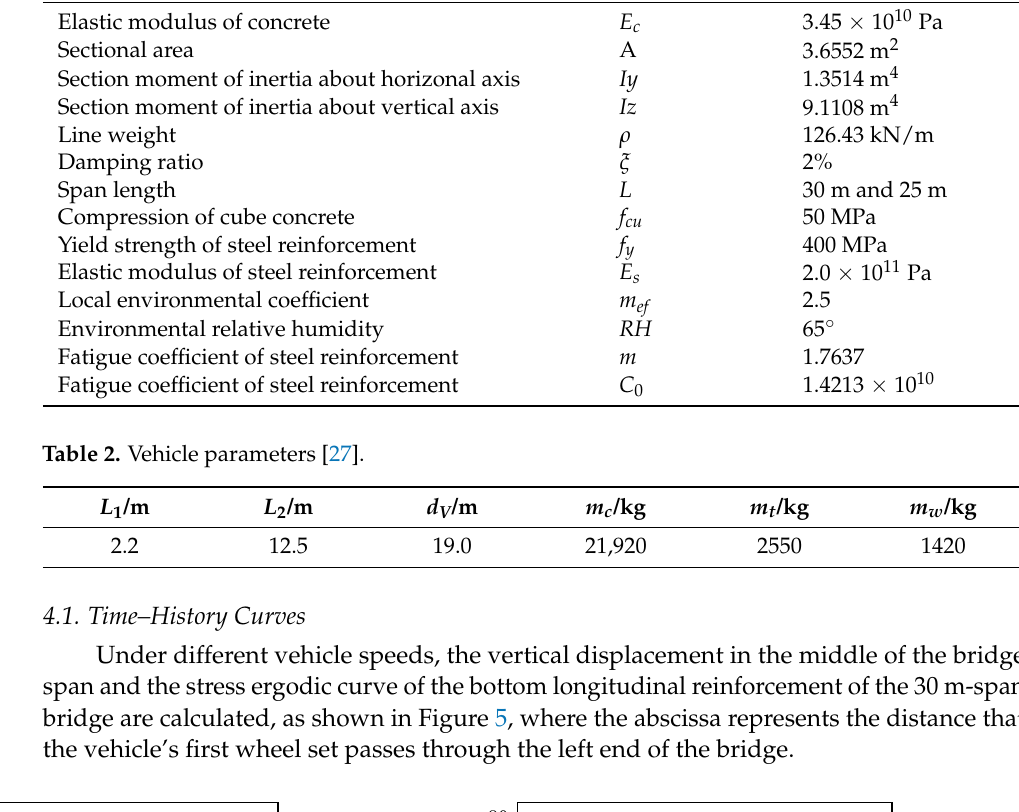
( b ) Stress Figure 6. Time–history response curves of midspan of 25 m-span bridge.